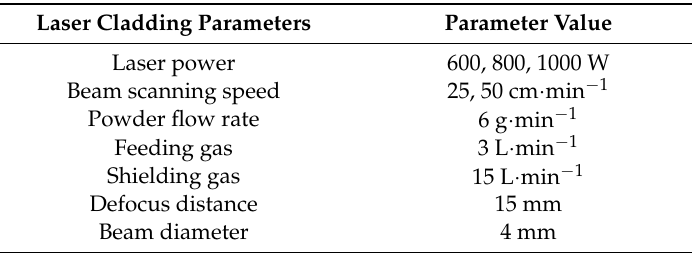
Table 2. Final attempts parameters for laser cladding